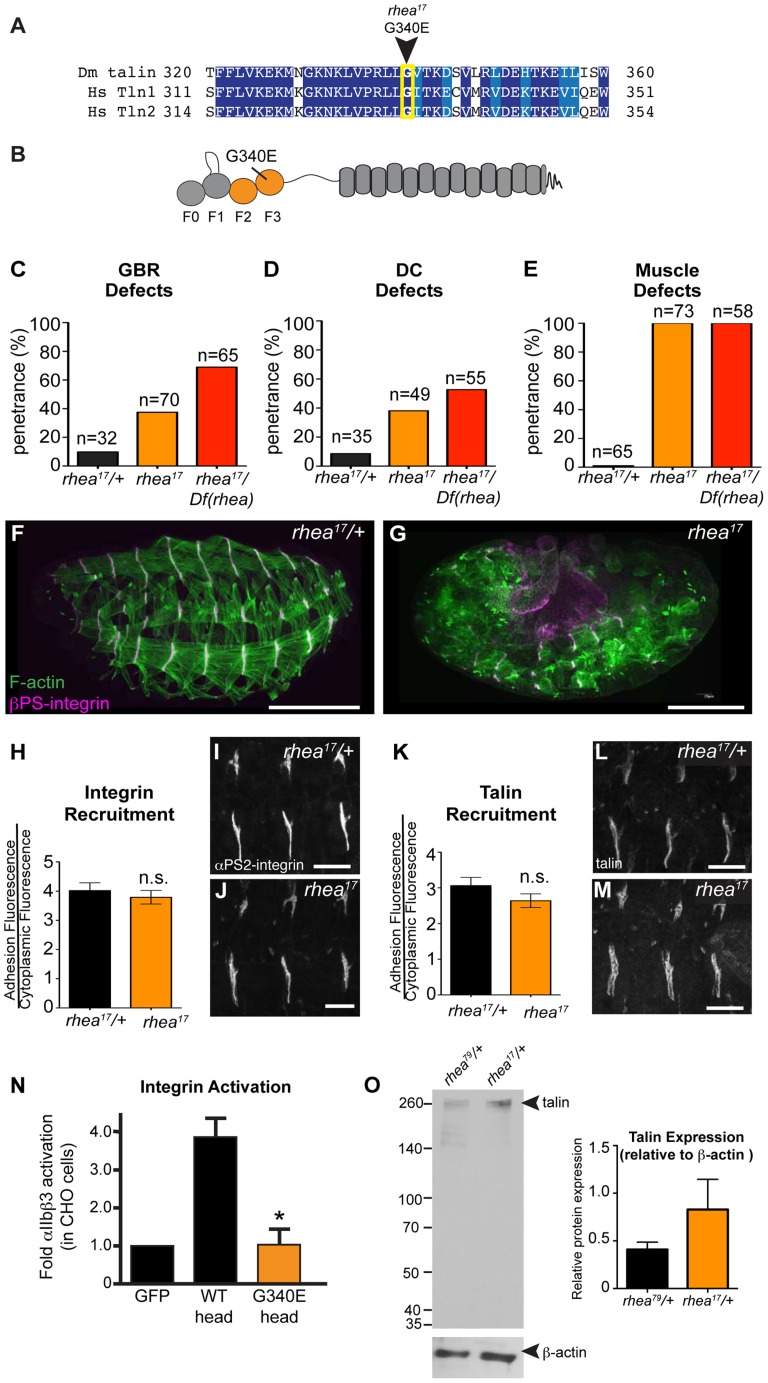

rhea17 encodes a hypomorphic talin protein which disrupts talin head function.(a–b) The rhea17 allele is characterized by a missense mutation in a conserved glycine residue in the F3 lobe of the talin head FERM domain, G340E. (c–g) Whole mount stage 17 embryos stained for F-actin (green) and integrin (magenta) reveal that rhea17 mutant embryos (g) harbour severe morphogenetic phenotypes in GBR (c) and DC (d), as well as muscle detachment defects (e) compared to WT heterozygous embryos (f). Phenotypic analysis of rhea17 over the rhea79 deficiency increased the penetrance of all phenotypes. (h–j) αPS2-integrin recruitment was measured in WT (h,i) and rhea17 (h,j) stage 16 embryonic muscles stained for integrin. Integrin was recruited at WT levels in rhea17 embryos. (k–m) Talin recruitment was measured in WT (k,i) and rhea17 (k,m) stage 16 embryonic muscles stained for talin. Talin was well recruited in rhea17 embryos. (n) Activation of human integrins by fly talin head constructs was measured in CHO cells. The G340E mutation was sufficient to abrogate integrin activation compared to WT. (o) Quantitative Western blot analyses of relative levels of talin normalized to beta-actin levels in flies heterozygous for either the rhea79 talin null mutation (left lane) or the rhea17 mutant allele (right lane). Scale bars: f–g = 100 µm; i–j; l-m = 20 µm.